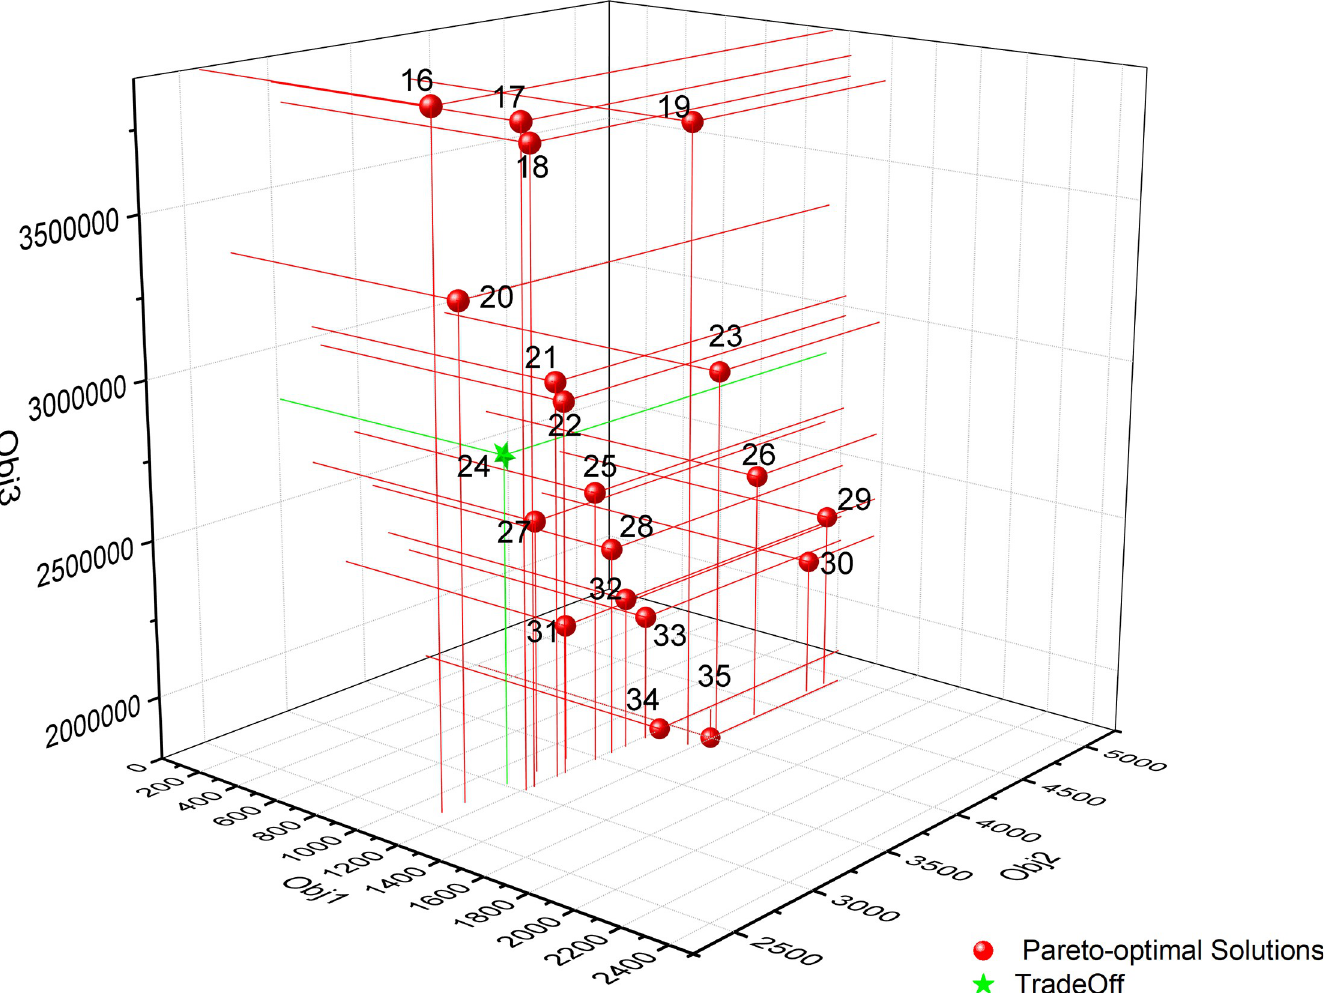
Fig 7. The distribution of the Pareto optimal solution of Model 3 in the three-dimensional coordinate system (p = 2).